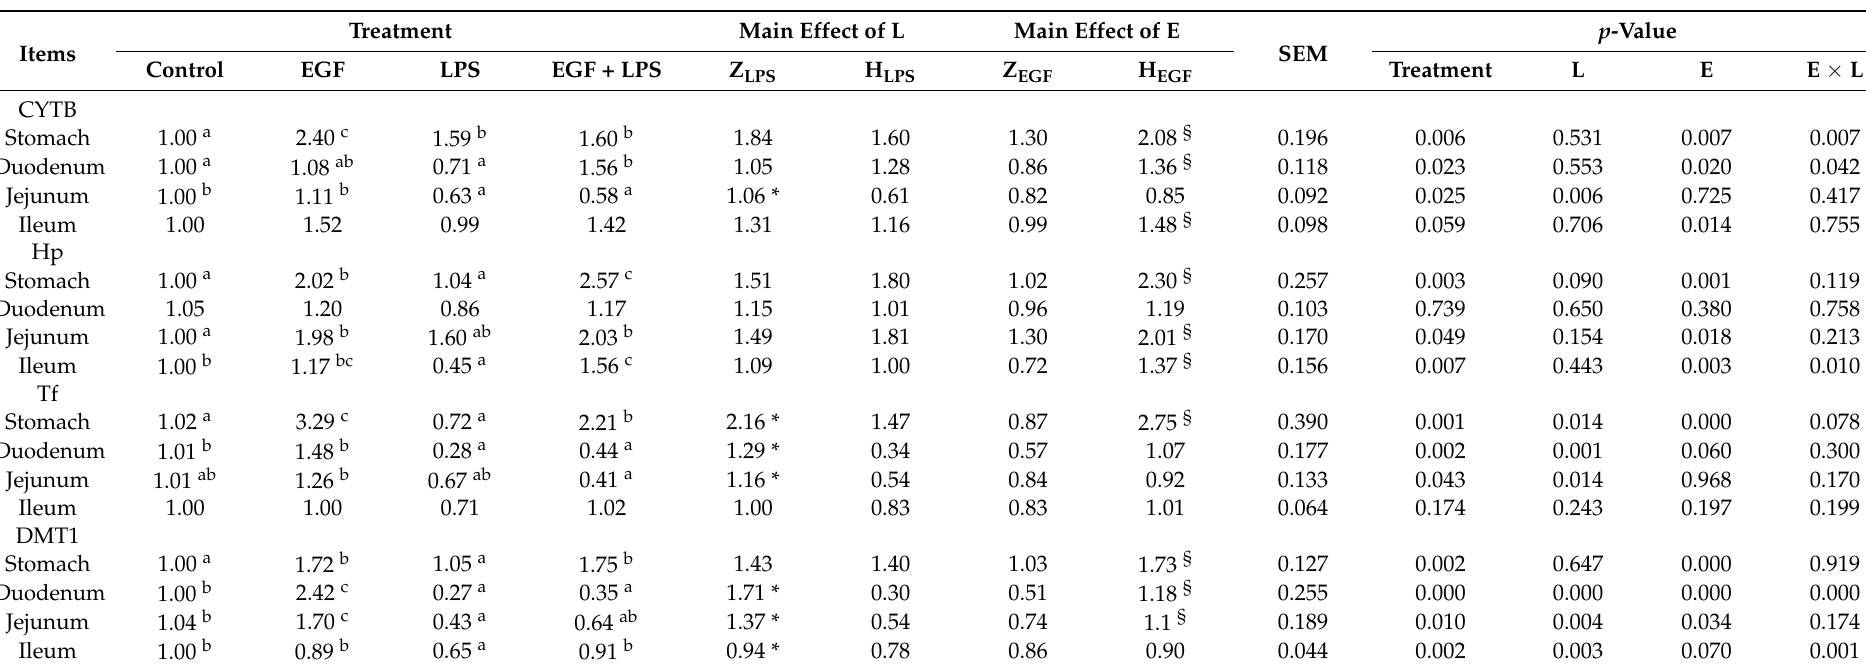
Table 7. EGF attenuates the effect of LPS on the expression levels of Fe transport-relative genes and DMT1 gene in the mucosa of gastrointestinal tract of early-weaning